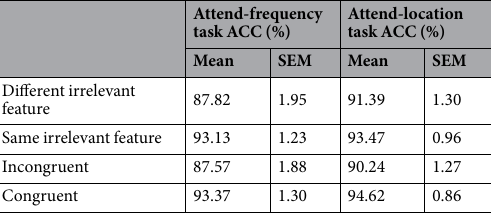
Table 2. Group mean and standard error of the mean accuracy levels from both TAiL tasks for different and same irrelevant feature changes, and incongruent and congruent feature